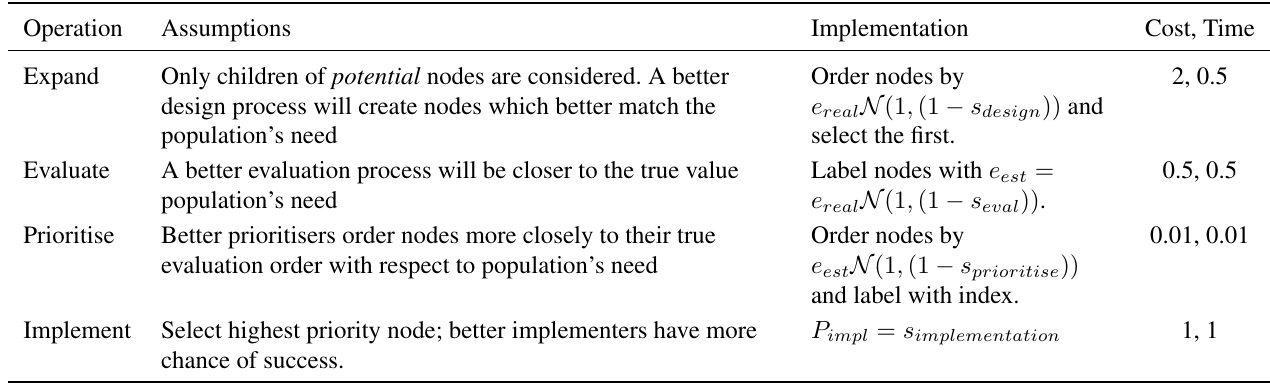
Table 1. Model of primitive tree operations, showing base costs, assumptions made and implementation details. e real is the true population utility for a feature tree, and s x is the team’s skill in x